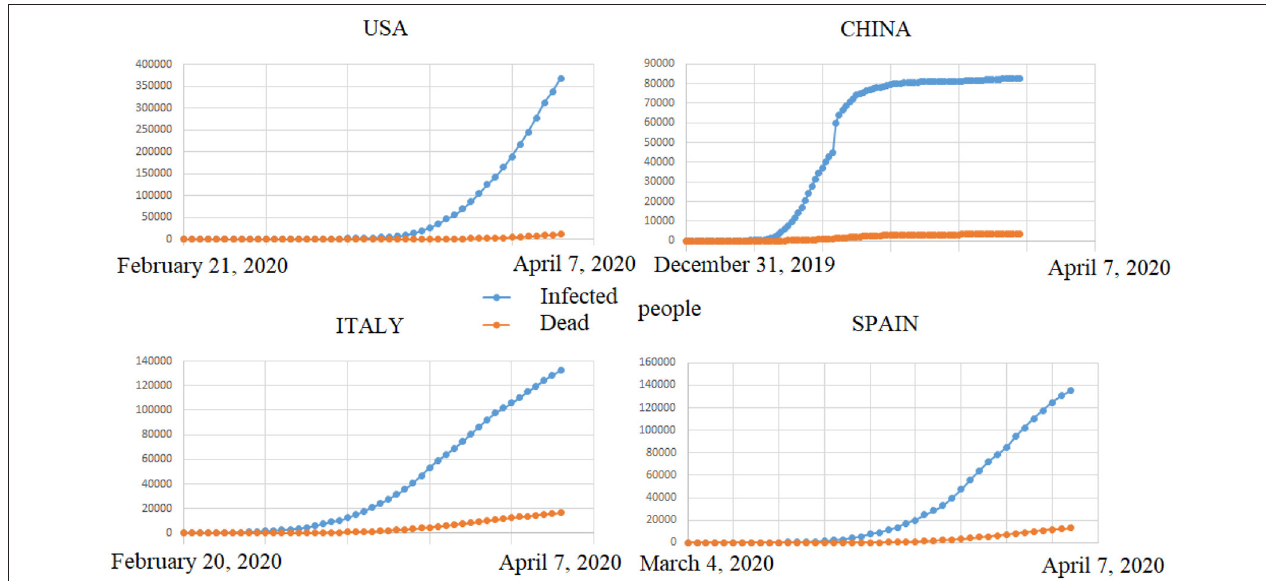
FIGURE 1 | Cumulative number of SARS-Cov-2 infected people (blue) vs. deaths (orange) per country as of the beginning of April, 2020. Data recoiled on https:// www.ecdc.europa.eu/sites/default/files/documents/COVID-19-geographic-disbtribution-worldwide.xlsx (April 8th, 2020).